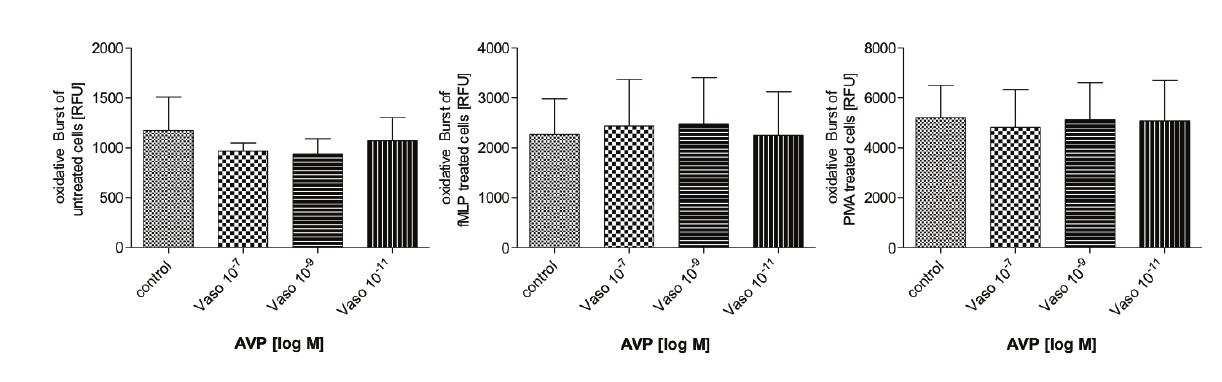
Figure 4: In vitro effects of AVP on oxidative burst Oxidative burst of (A) unstimulated, (B) N-formyl-Met-Leu-Phe (fMLP) and (C) phorbol 12-myristate 13-acetate (PMA)-stimulated polymorpho- nuclear leukocytes (PMN); PMNs were incubated with various concentrations of AVP ranging from 10-7 to 10-11 M or control; Graph shows mean ± standard deviation; n = 5; RFU, relative fluorescence